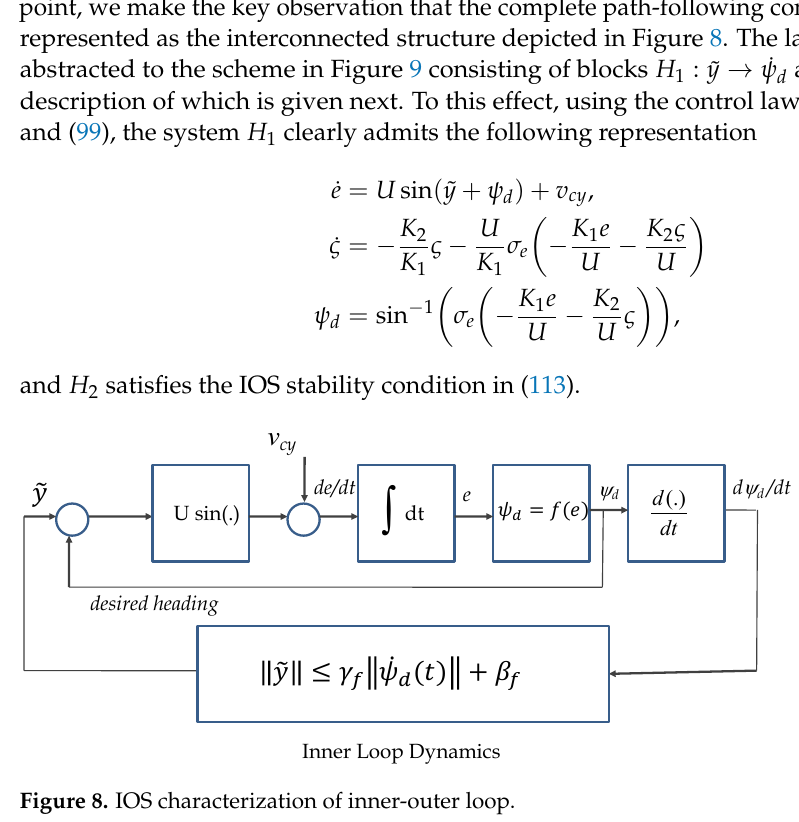
Figure 8. IOS characterization of inner-outer loop.